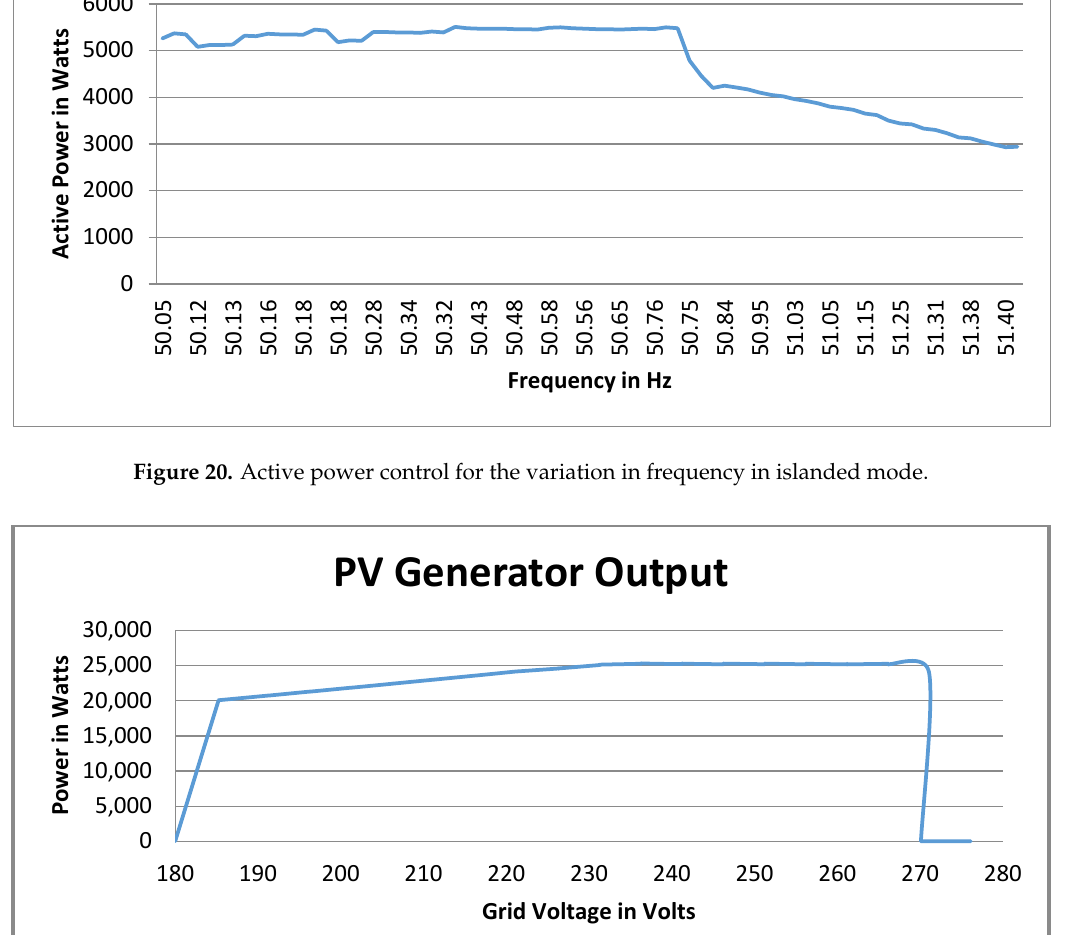
Figure 21. Active power derating with increase in grid voltage in islanded mode of operation.